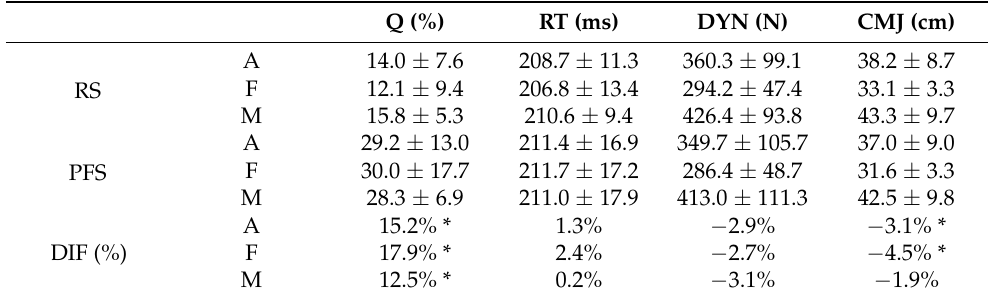
Table 3. Reference parameter values. Average (mean ± SD) values for the reference parameters in the rested state (RS), physically-fatigued state (PFS) and their difference in percentage (DIF). Results are shown for the whole study group (A), female subgroup (F) and male subgroup (M). Q—questionnaire, RT—reaction time, DYN—dynamometer hand grip force and CMJ—countermovement jump height. Values marked with asterisk (*) indicate statistical difference (paired t -test, p <